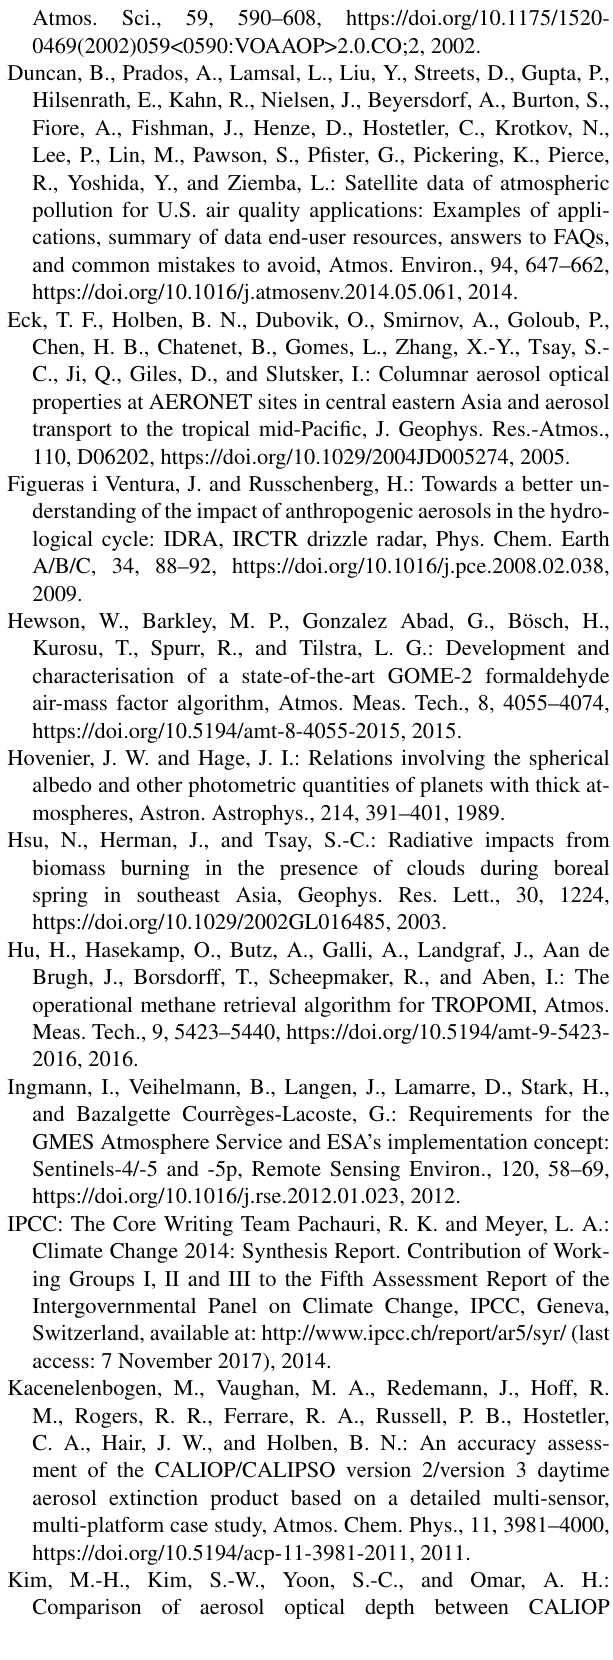
Figueras i Ventura, J. and Russchenberg, H.: Towards a better